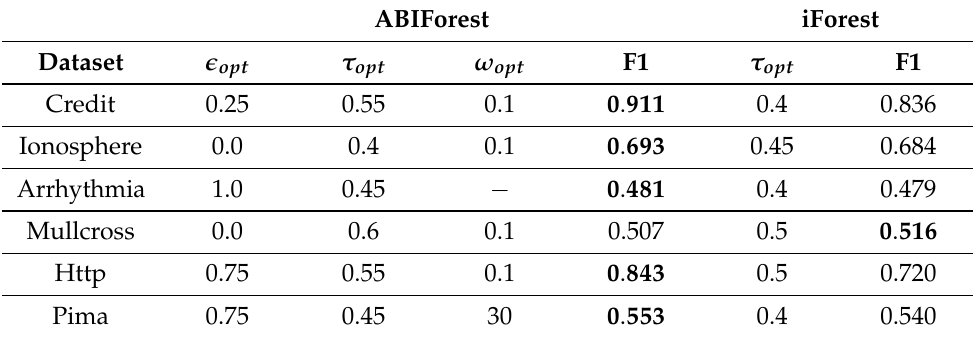
Table 7. F1-score measures of ABIForest consisting of T = 150 trees for different real datasets with the optimal values of τ , (cid:101) , and ω and the F1-score measures of iForest with the optimal values of τ .